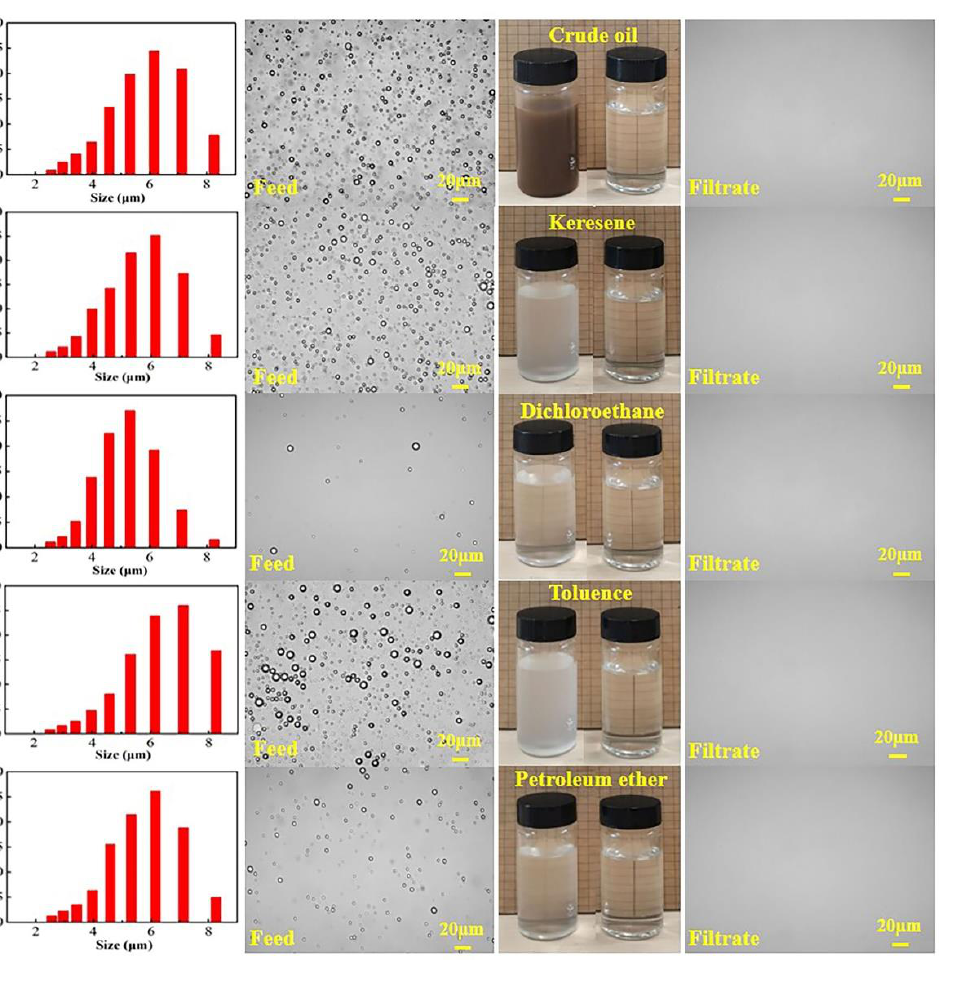
Figure 8. Photographs and optical microscopy images of feed emulsions and filtrates, and oil particle size distribution of the original emulsions. Table 3. The TOC results for emulsions before and after filtration.